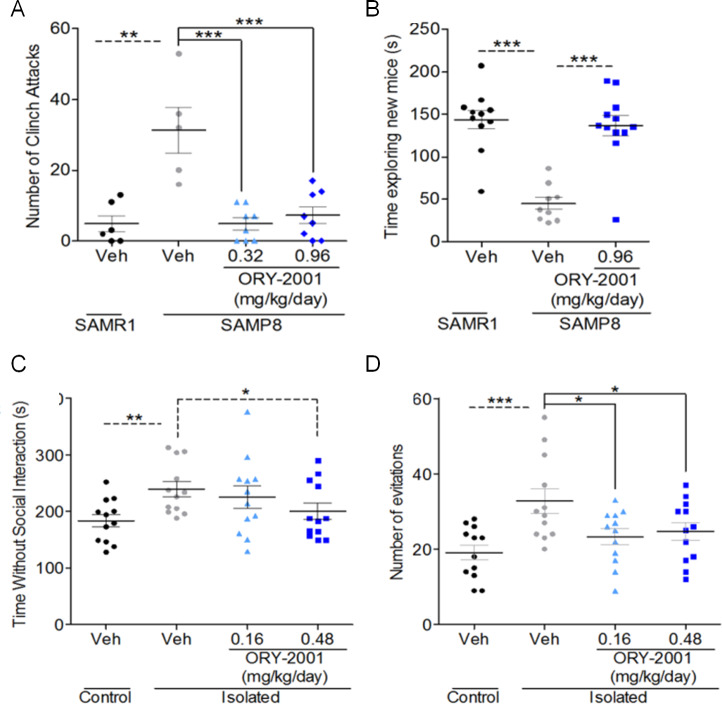
Inhibition of KDM1A with ORY-2001 remedies behavior alterations.Effect of ORY-2001 on SAMP8 mice: (A) aggressive behavior as assessed by the total number of clinch attacks in the resident intruder test (F2,18 = 16.76; p < 0.0001; N = 5–8 males/ group) and (B) social interest as assessed by the time exploring the new mice in the three chamber test (t(19) = 6.008; p < 0.0001; N = 9–12 females/group). Effect of ORY-2001 on social behavior of rats in the isolation rearing model in the Resident Intruder test reflected by (C) the time spent without social interaction and (D) the number of active avoidances. ORY-2001 reduced both the time without social interaction (t(22) = 2.094; p = 0.048) and the number of social avoidances (F2,33 = 4.941; p = 0.013) (N = 12/group). Means and SEM are represented. SAMR1 and SAMP8 or Non Isolated and Isolated vehicle groups were compared by t-Test. Among the SAMP8 or Isolated groups, different drug treatments were compared by one way-ANOVA with Dunnett and SNK post-hoc analysis. *p < 0.05, **p < 0.01, ***p < 0.001.